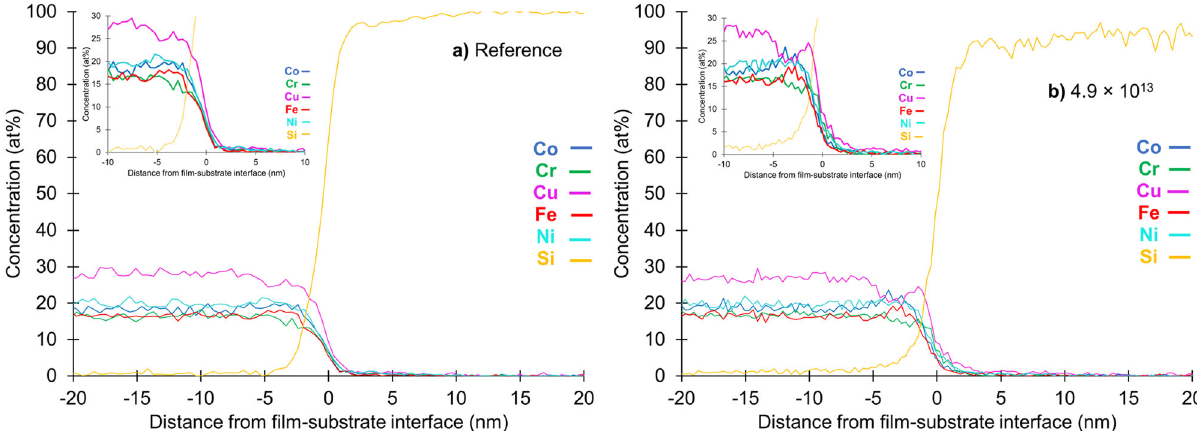
Fig. 11 Concentration pro fi les across the fi lm – substrate interface highlight the initial compositional fl uctuation after very low fl uence Au-ion irradiation. STEM-EDS concentration pro fi les normal to the interface of the a as-grown fi lm and the b fi lm irradiated to a fl uence of 4.9 × 10 13 cm − 2